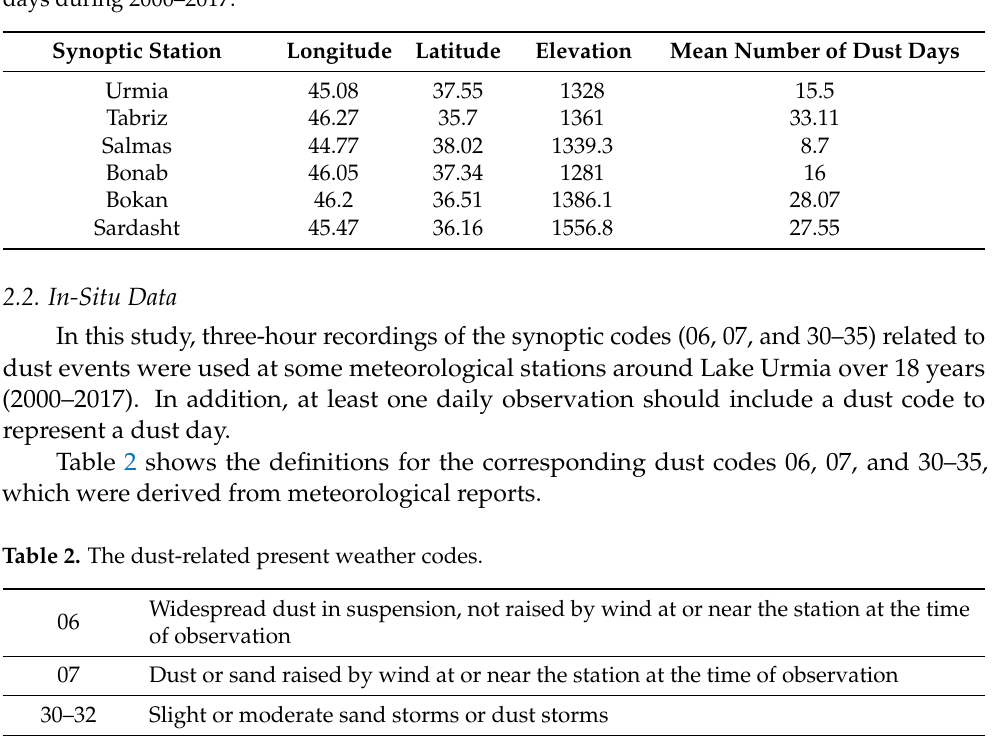
Table 1. The six synoptic weather stations around Lake Urmia and the mean annual number of dust days during 2000–2017.